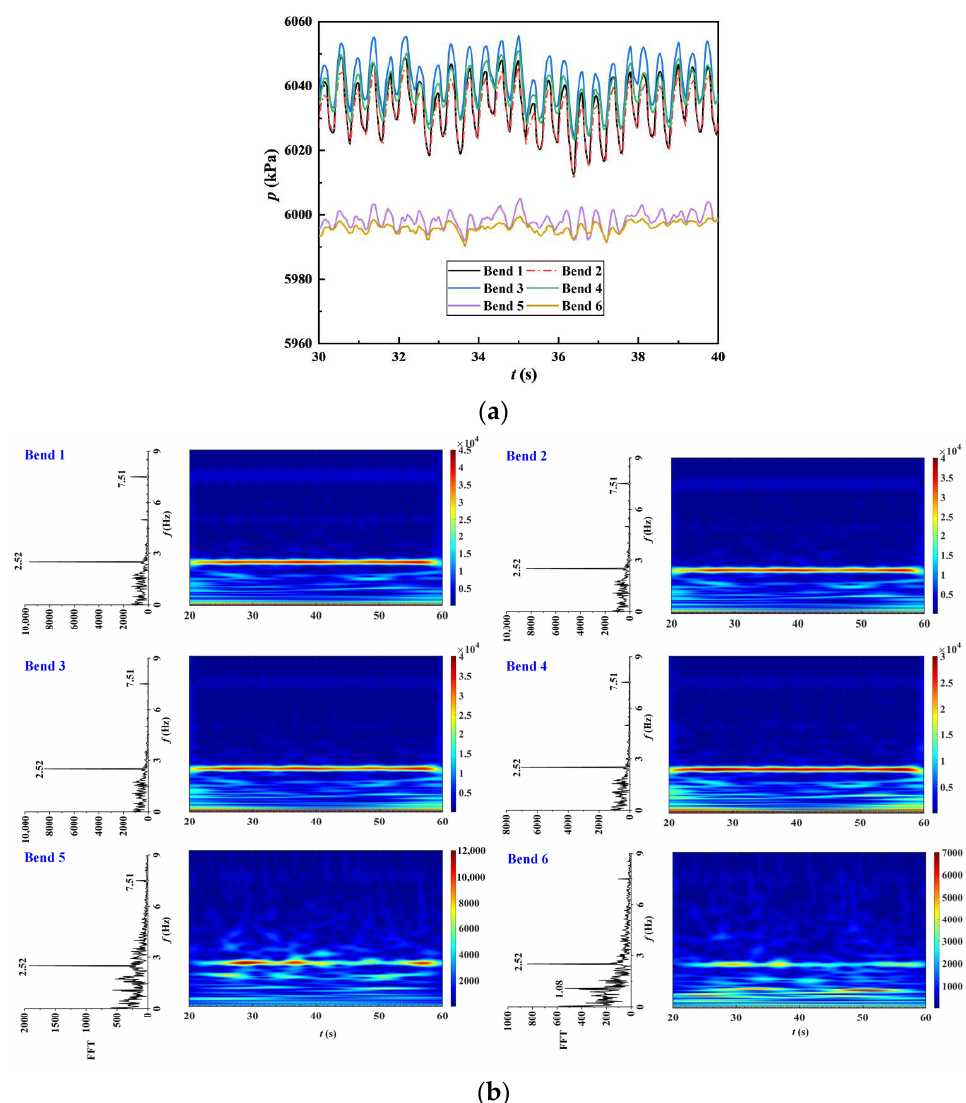
Figure 8. The variation of pressure ( p ) acting on the bends of the static jumper over time in case 1, where f is the fluctuation frequency and t is the flow time: ( a ) time series of pressure exerted on the bends’ surface; ( b ) frequency spectrum of pressure fluctuation.